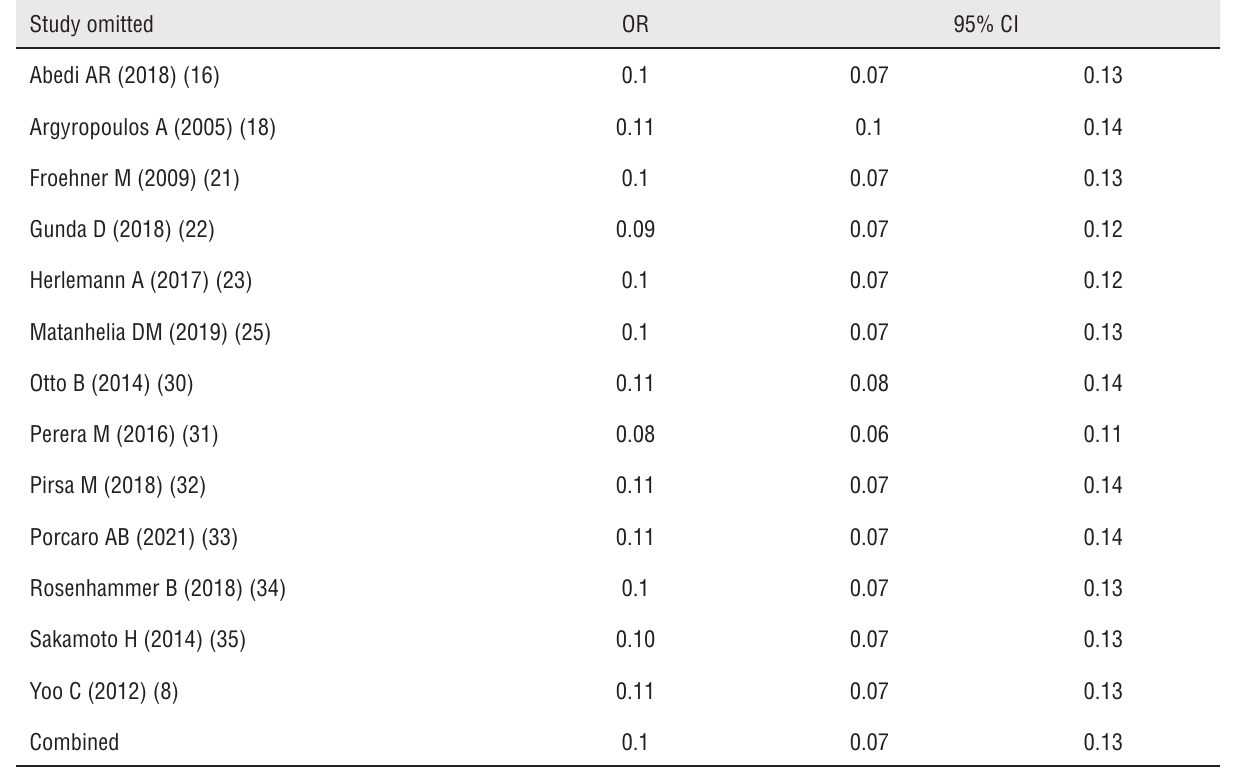
Table 2 - Results of sensitivity